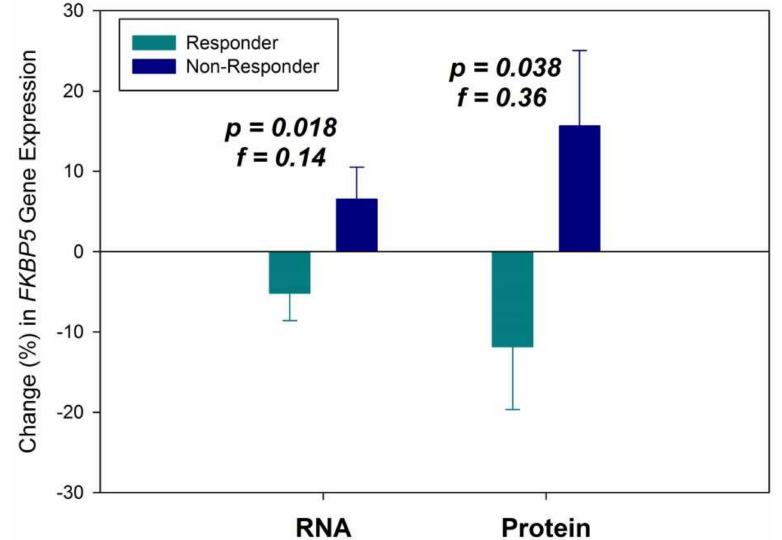
Figure 1. Change (% from baseline) in FKBP5 gene expression for RNA and protein after six weeks of antidepressant treatment in responders and non-responders. Means ± standard errors of the mean (SEM) are